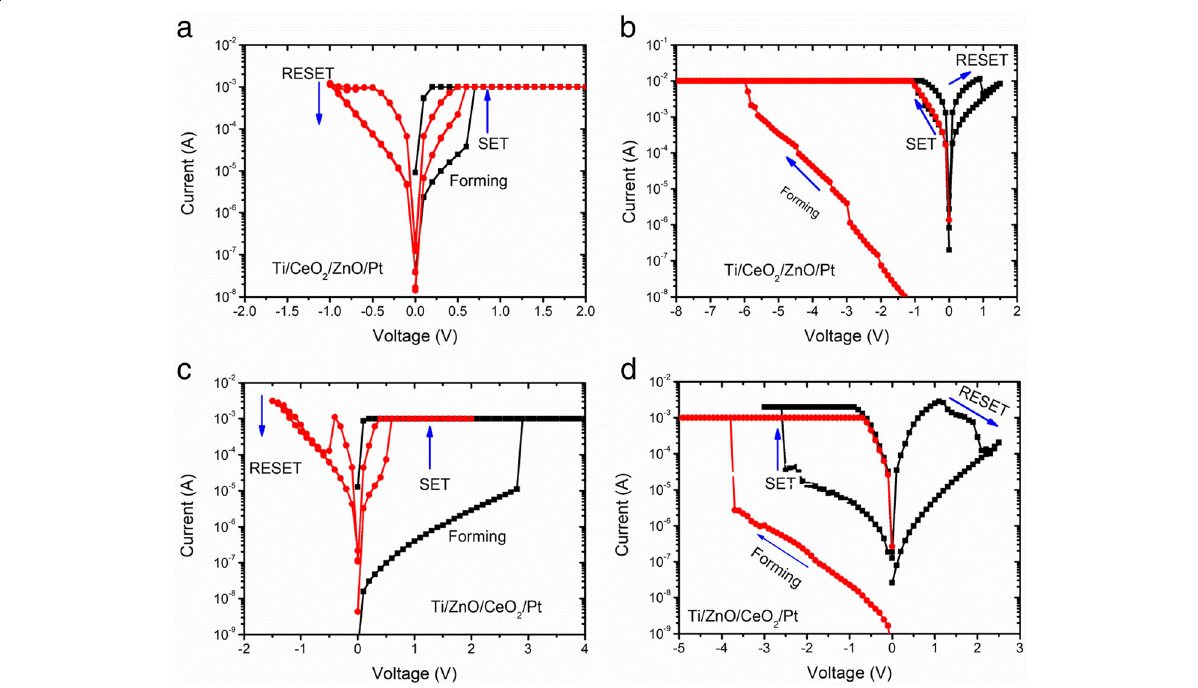
Fig. 2 Devices depict the typical bipolar behavior. a Positive (+ve) forming and subsequent switching operation and b negative ( − ve) forming and switching operation of the Ti/CeO 2 − x /ZnO/Pt hetrostructures. c +ve forming and switching operation and d − ve forming and switching operation of Ti/ZnO/CeO 2 − x /Pt memory devices. Arrows indicate switching